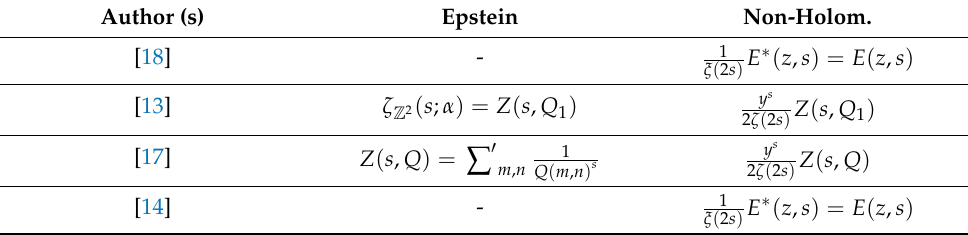
Table 2. Epstein zeta-functions and non-holom. Eisenstein